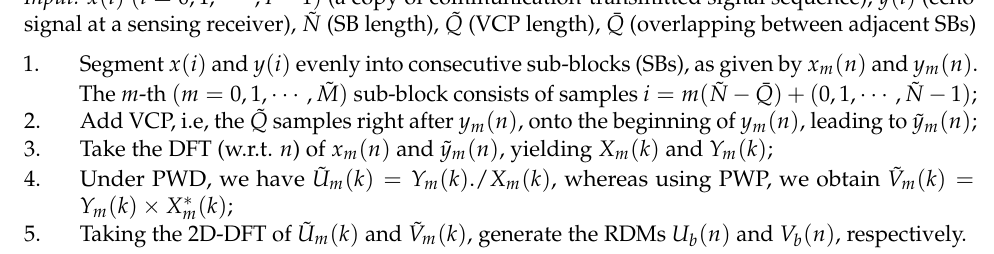
Algorithm 1 A novel sensing framework